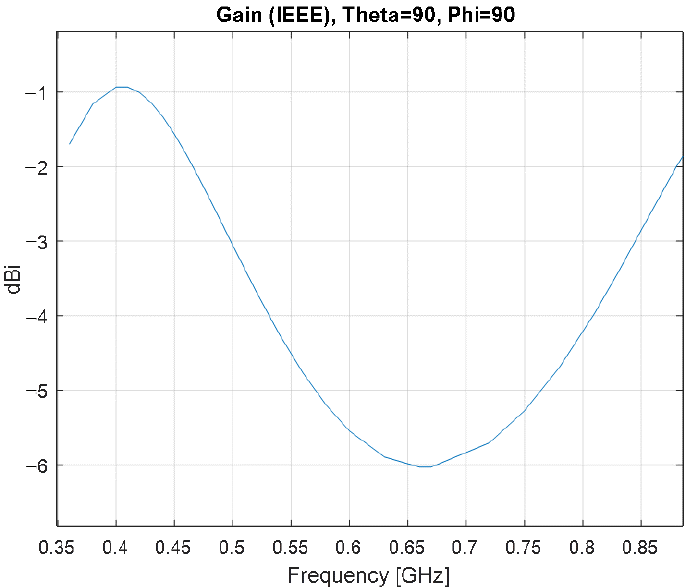
Figure 18. Gain variation over frequency for the simulation model of the meander line monopole antenna with impedance matching at 𝜃 = 90 deg. and 𝜑 = 90 deg.